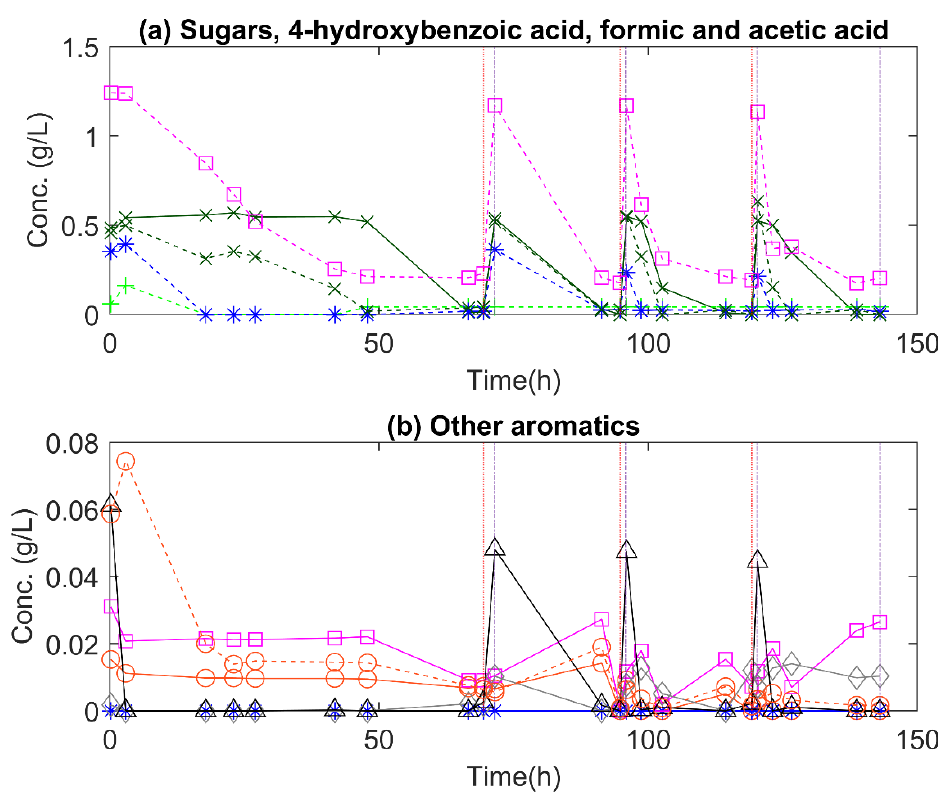
Figure 4. Substrate consumption by C. oleaginosum as measured by HPLC, with ( a ) presenting the concentration of (-x-) 4-hydroxybenzoic acid, (- -+- -) glucose, (- -*- -) xylose, (- -x- -) formic acid, (-- □ --) acetic acid, and ( b ) presenting the concentration of (- ○ -) 5-HMF,(-+-) furfural, (-*-) 3,4-dihydroxybenzaldehyde, (- □ -) vanillic acid, (- ♢ -) syringic acid, (- △ -) vanillin, and (- - ○ - -) syringaldehyde. Vertical dotted lines (···) indicate the start of the harvest phase, while vertical dash-dotted lines (-·-·) indicate the start of the second, third, and fourth cycle. The concentrations presented are the result of one measurement.